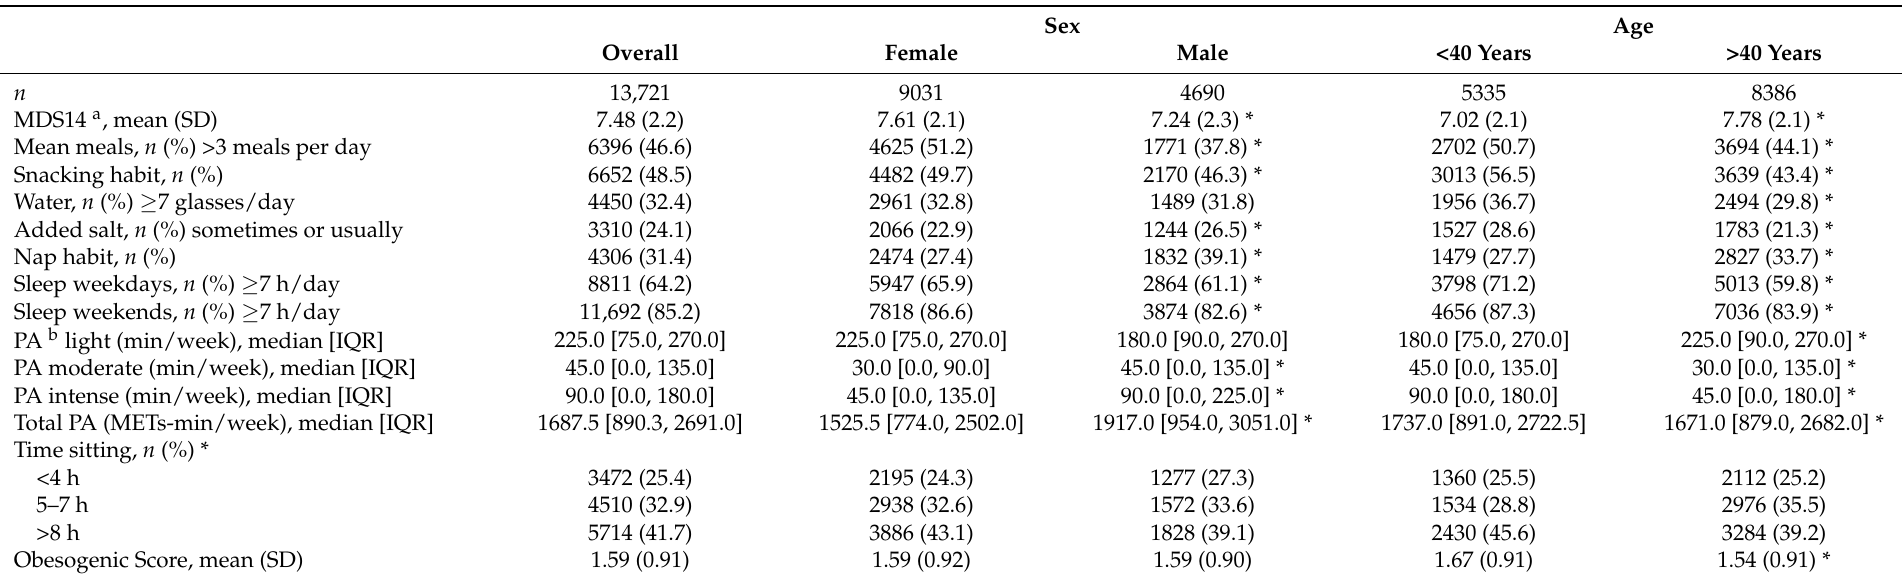
Table 2. The characteristics of the participants in the NUTRiMDEA study according to the lifestyle distributed by sex and age. Sex Age Overall Female Male <40 Years >40